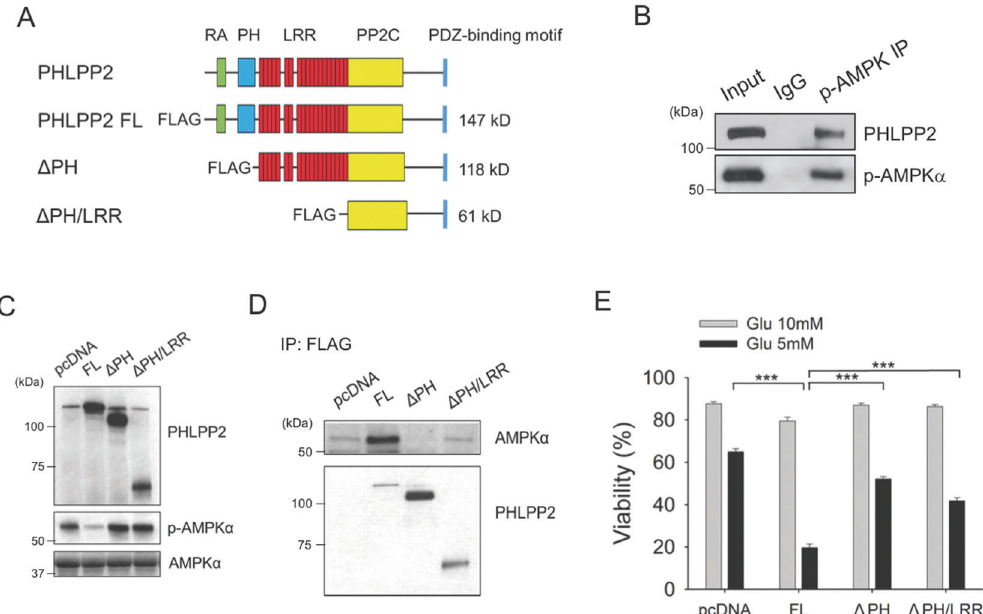
Fig. 3 PHLPP2 interacts with endogenous AMPK and the PH domain is required for the interaction, phosphatase activity, and the response to glucose limitation. A Domain structure of FLAG-tagged full length and deletion mutants of human PHLPP2 used in transfection studies and phosphatase assays. RA Ras-Associated domain. PH Pleckstrin Homology domain. LRR Leucine-Rich Repeat domain. PP2C Protein Phosphatase 2C domain. B Endogenous PHLPP2 co-immunoprecipitates with phospho-AMPK α in Jurkat cell extracts. C Over-expression of full-length PHLPP2 induces dephosphorylation of AMPK α in Jurkat cells. WB of lysates from Jurkat cells transfected with empty vector, PHLPP2 full-length (FL), PH domain deleted ( Δ PH), and PH/LRR domain deleted ( Δ PH/LRR) constructs showing expression of transfected proteins and the phosphorylation of AMPK α (T172). D Full-length FLAG-tagged PHLPP2, but not the PH domain deleted mutant, interacts with AMPK α . Lysates from Jurkat cells transfected with the indicated construct were subjected to immunoprecipitation with anti-FLAG antibody 72 h after transfection. Immunoblots were probed for AMPK α and PHLPP2. E The PH domain is required for the death-promoting effect of over- expressed PHLPP2 under metabolic stress. Jurkat cells were transfected with the indicated constructs and 24 h later, cells were cultured